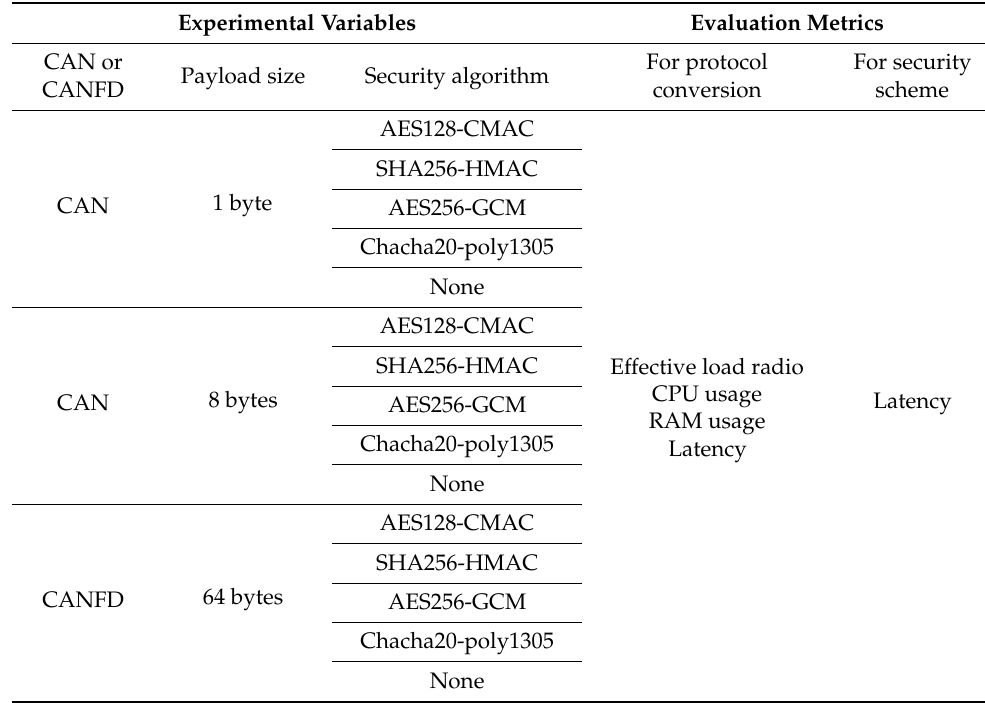
Table 5. Experiments settings and evaluation metrics.